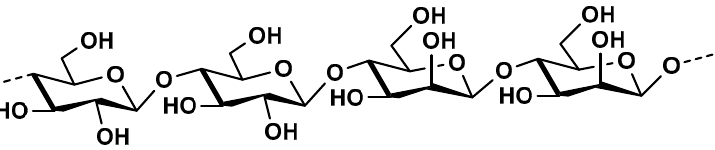
Figure 7. Main chemical structure of glucomannans.